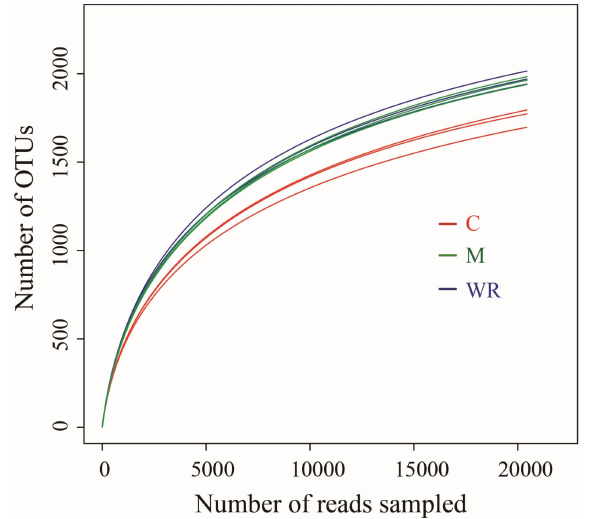
Figure 2. Rarefaction curves of the number of operational taxonomic units (OTUs) of cucumber rhizosphere bacterial communities. Random subsamples of 20,445 16S rRNA gene sequences per sample were used to generate the rarefaction curves. C, M and WR represent treatments of cucumber monocropping, rotations with Indian mustard and wild rocket,